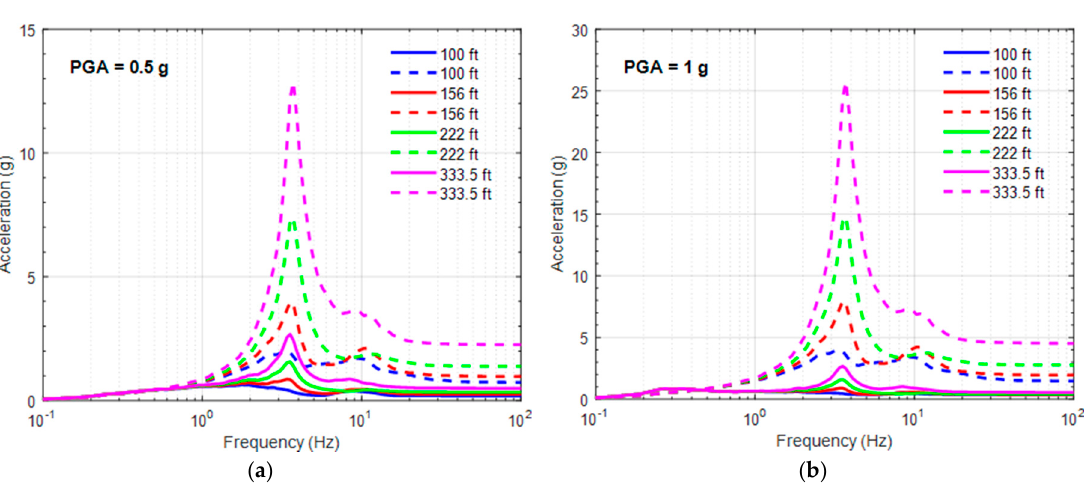
Figure 12. FRS of a base-isolated RCB at various PGA levels: ( a ) PGA = 0.2 g; ( b ) PGA = 0.3 g; ( c ) PGA = 0.5 g; ( d ) PGA = 0.75 g; ( e ) PGA = 1 g; ( f ) PGA = 1.25 g.